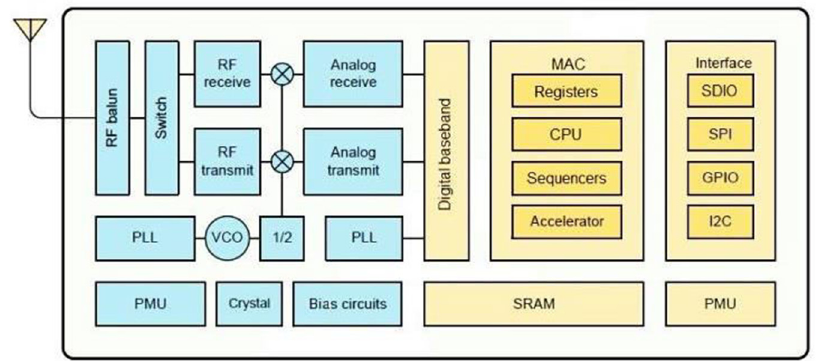
Figure 8. ESP8266 equipment.